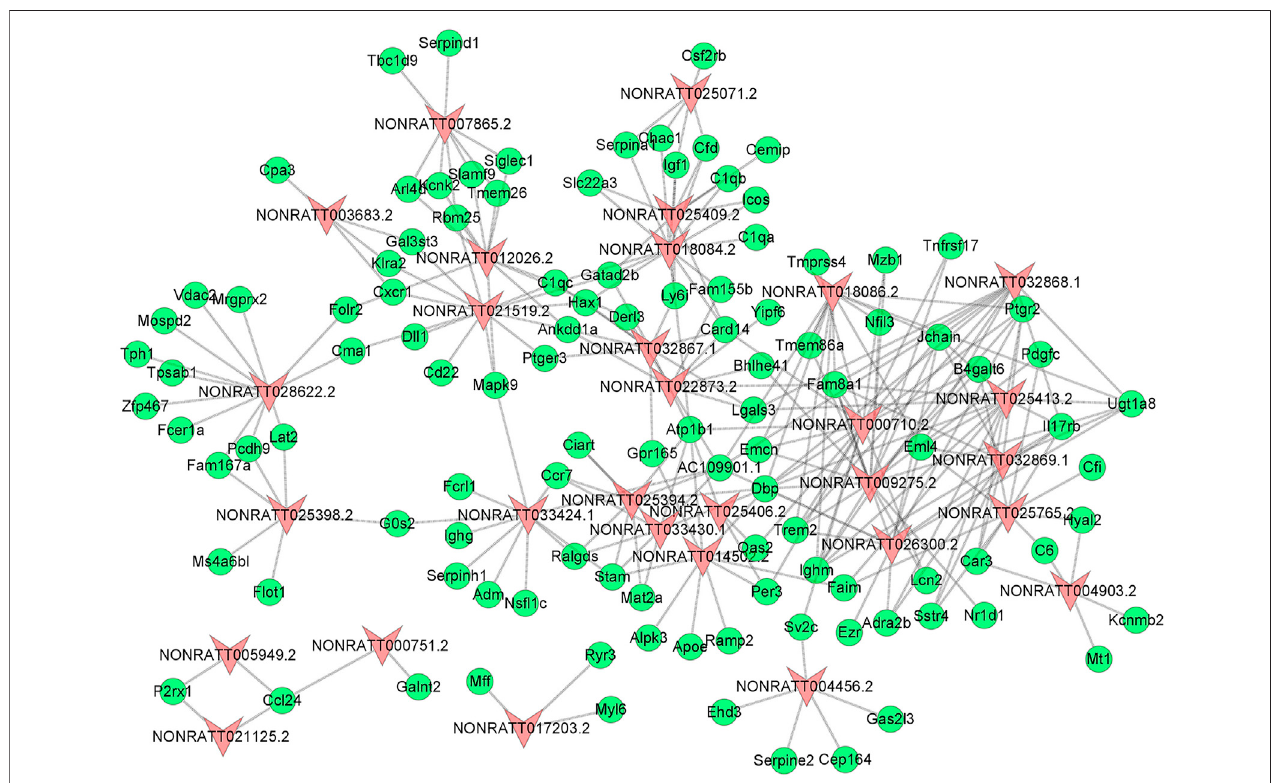
FIGURE 3 | The lncRNA-mRNA Co-Expression Network. The red triangle nodes represented differentially expressed lncRNAs, and the green oval nodes represented differentially expressed mRNAs. The edges showed the interactions between lncRNAs and mRNAs.